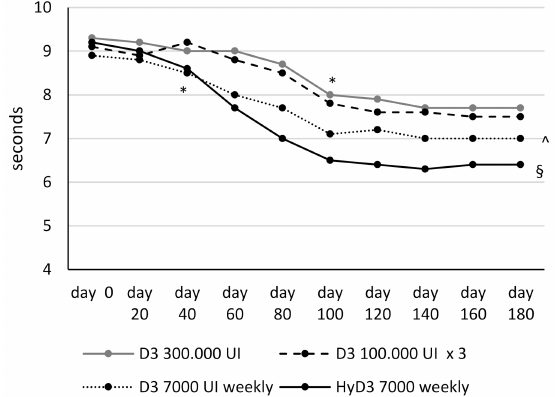
Figure 4. Time Up and Go test. *: p < 0.05 vs. baseline; §: p < 0.05 vs. Group 1, 2, 3; ˆ: p < 0.01 vs. Group 1, 2. D3 = cholecalciferol; HyD3 = calcifediol. Group 1 cholecalciferol 300,000 UI single dose; Group 2 cholecalciferol 100,000 every two months; Group 3 cholecalciferol 7000 UI weekly; Group 4 calcifediol 7000 UI